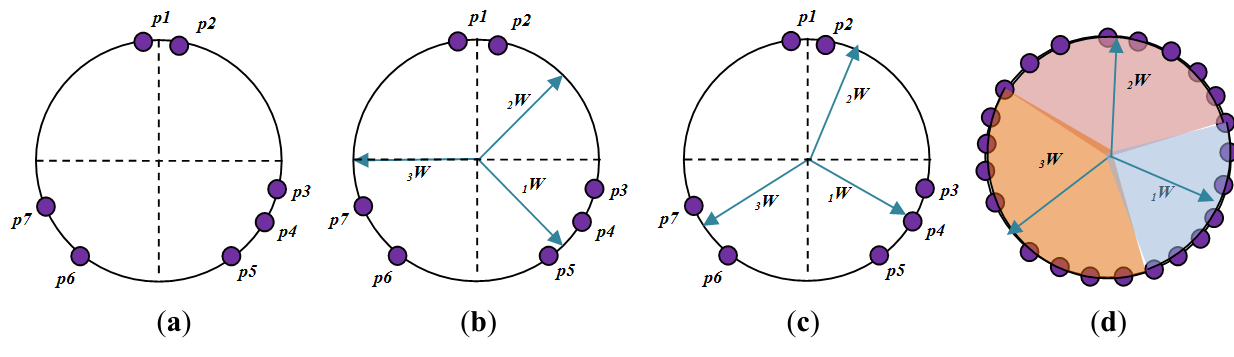
Figure 4. Graphical representation of competitive layer learns to classify input